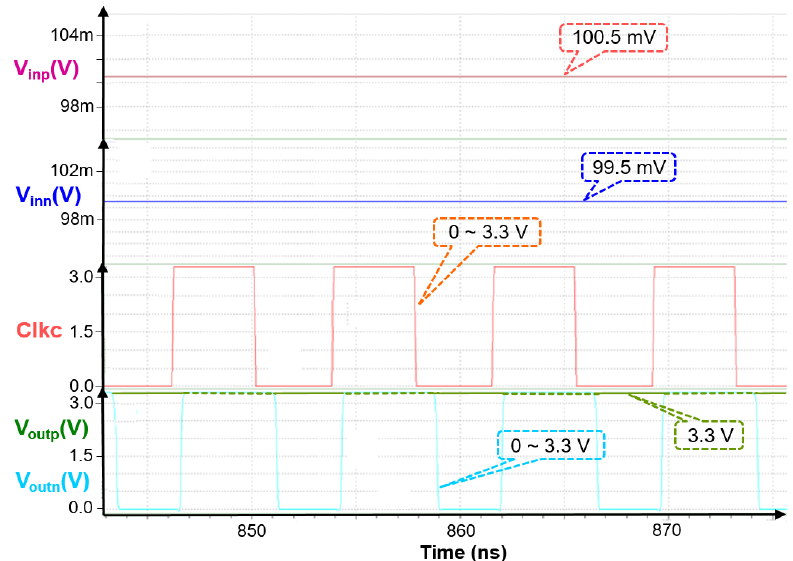
Figure 16. Simulated output waveforms V outp and V outn of the modified dynamic comparator at the constant common-mode voltage of 100 mV and differential input voltage of 1 mV.